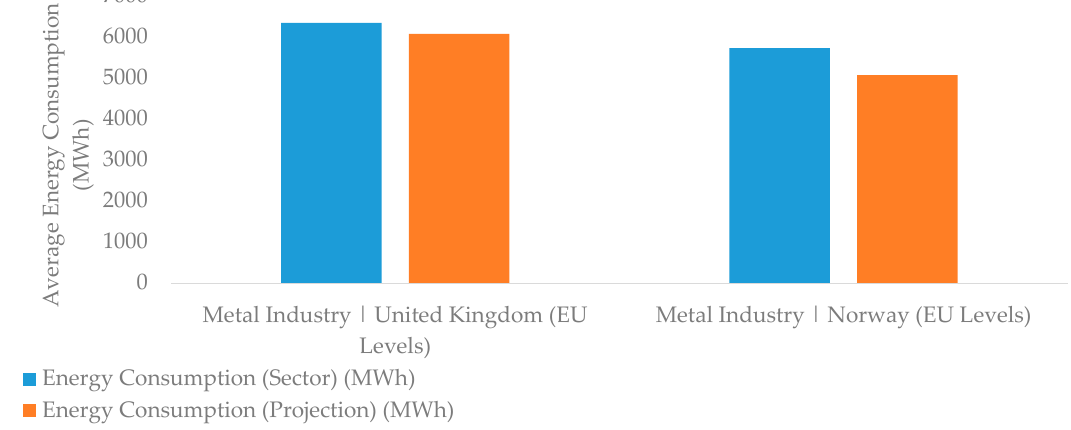
Figure 10. Potentials for savings in energy consumption for each approached industrial sector in the United Kingdom and Norway (based on the average levels of the European Union).